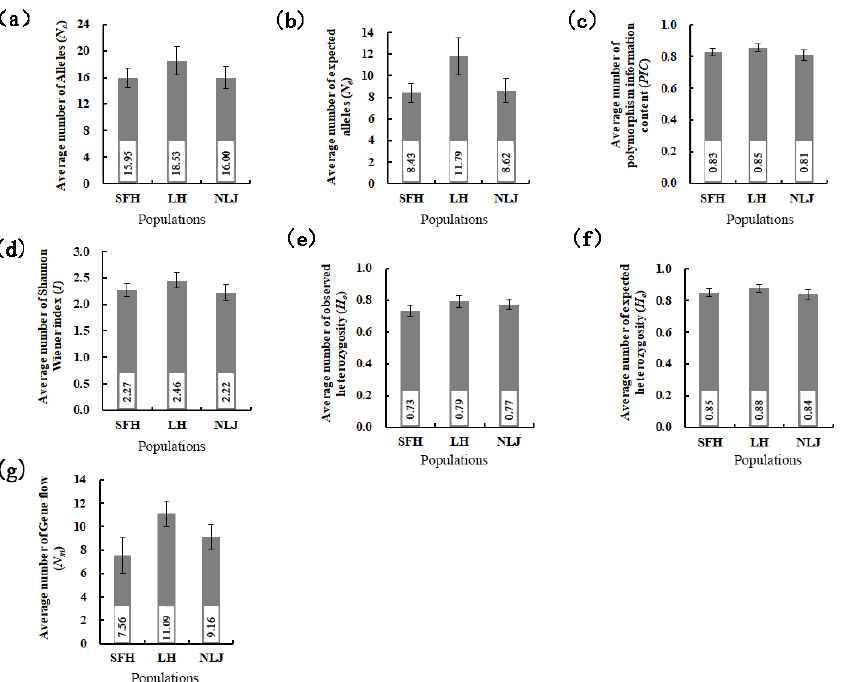
Figure 4. Genetic diversity parameters for three Eriocheir s. s. populations. ( a ) Average number of observed alleles ( N a ); ( b ) average number of expected alleles ( N e ); ( c ) average number of polymorphic information content ( PIC ); ( d ) average number of Shannon Wiener index ( I ); ( e ) average number of observed heterozygosity ( H o ); ( f ) average number of expected heterozygosity ( H e ); and ( g ) average number of gene flow ( N m ) estimated after screening 19 microsatellite loci in three wild Eriocheir s. s. populations.